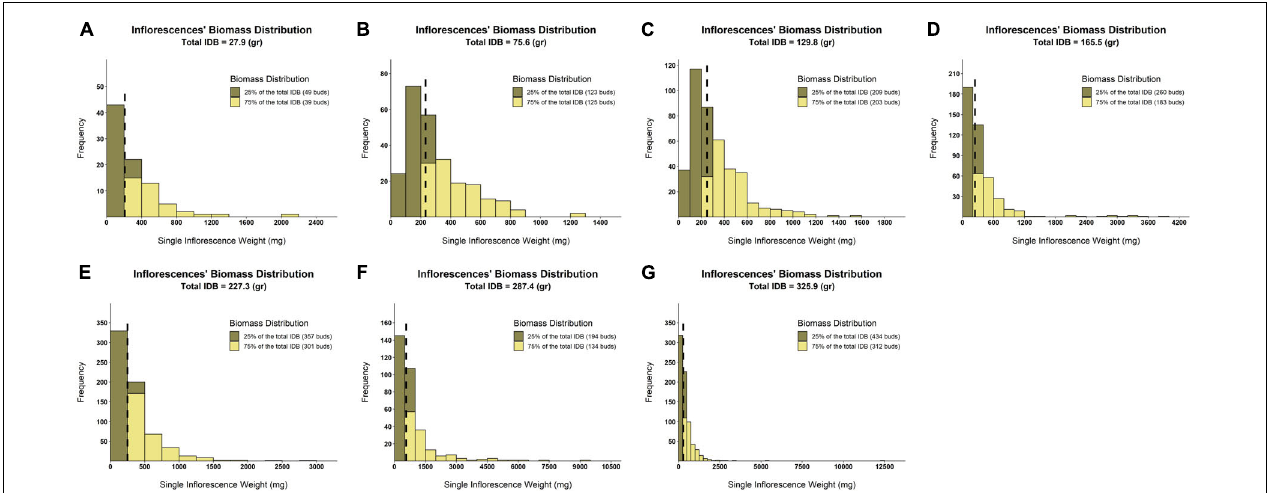
FIGURE 7 | Distribution histograms of within-plant inflorescences’ weight across various levels of IDB. Surfaces colored in khaki represent the quantity of smaller inflorescences that contributes to the accumulation of 25% of plant IDB. Surfaces colored in yellow reflect the quantity of larger inflorescences that contributes to the accumulation of 75% of plant IDB. Black broken lines indicate the inflorescences’ weight median for each of the examined plants. (A) IDB = 27.9 (gr/plant), (B) IDB = 75.6 (gr/plant), (C) IDB = 129.8 (gr/plant), (D) IDB = 165.5 (gr/plant), (E) IDB = 227.3 (gr/plant), (F) IDB = 287.4 (gr/plant), and (G) IDB = 325.9 (gr/plant). and phenological traits. The examined germplasm